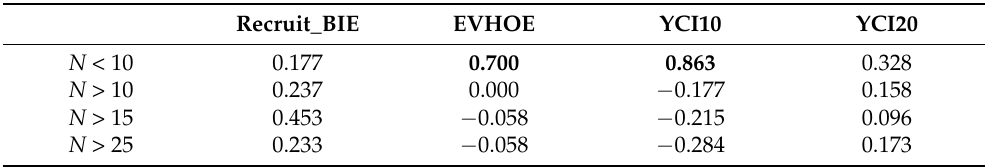
Table 6. Correlation coefficients (bold and significant at p < 0.05) for the various indices of year–class strength and larval abundance (see Table 3 for